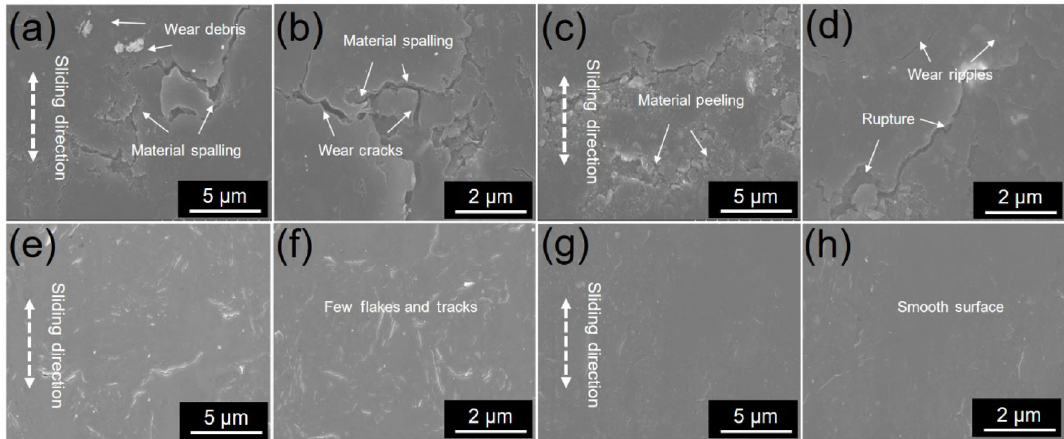
Fig. 5 SEM micrographs of wear tracks under a load of 8 N: non-impregnated graphite at 20 °C (a, b) and at 160 °C (c, d); impregnated graphite at 20 °C (e, f) and at 160 °C (g,